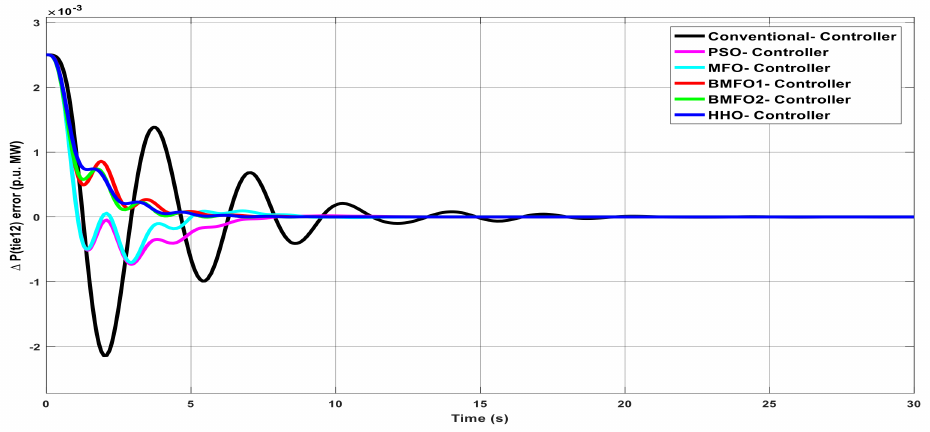
Figure 12. Deviation in tie-line error with various controller under bilateral contract.